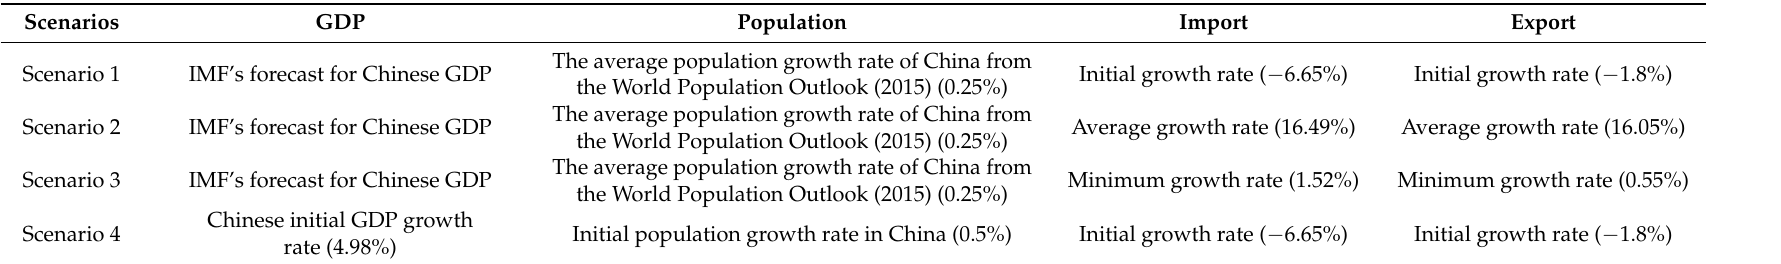
Table 3. The forecasting scenarios of Chinese energy consumption (2015–2021).